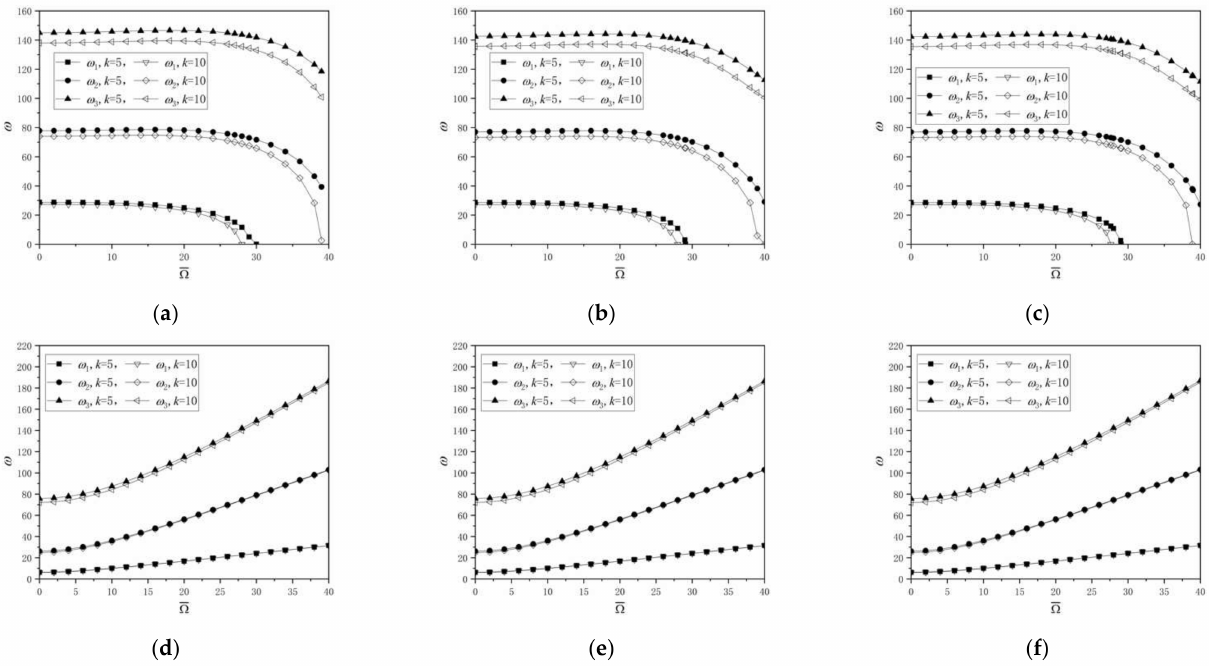
Figure 3. The relationship between dimensionless natural frequencies and the rotational velocity under two different boundary conditions. ( a ) C-C Kirchhoff plate; ( b ) C-C Mindlin plate; ( c ) C-C Reddy plate; ( d ) C-F Kirchhoff plate; ( e ) C-F Mindlin plate; ( f ) C-F Reddy